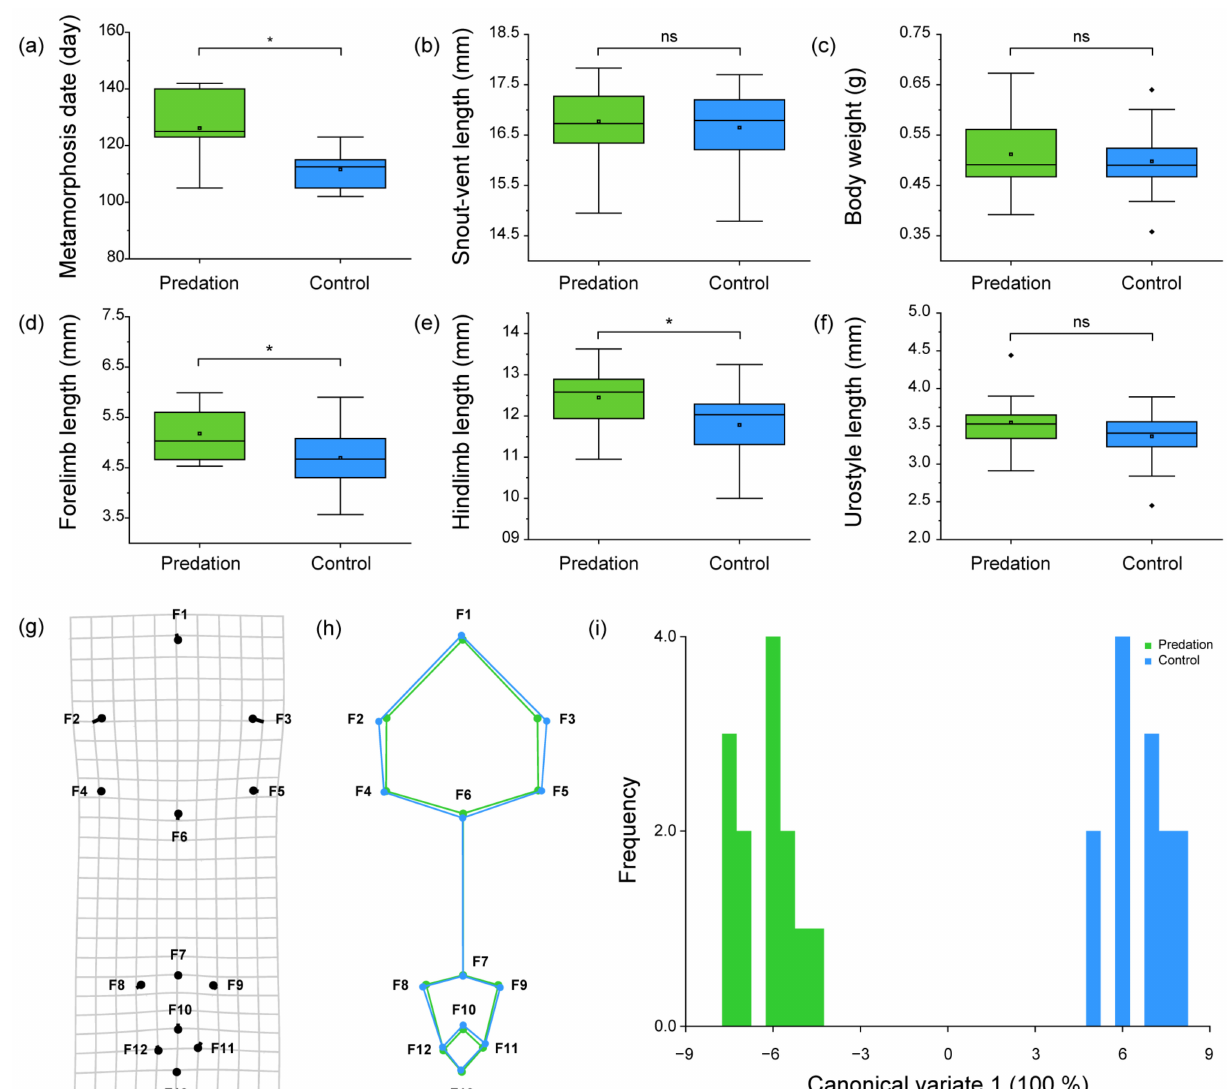
Figure 5. Comparison of the: ( a ) metamorphosis rate; ( b ) snout–vent length; ( c ) body weight; ( d ) forelimb (i.e., the humerus and radio–ulna) length; ( e ) hind limb (i.e., the femur and tibio–fibula) length; ( f ) urostyle length; and ( g – i ) the skeletal shape of the head and lower body of the juvenile frogs (Gosner stage 46) between the predation and control groups; ( g ) the rectangular grid with landmark points and vectors of the canonical variate 1 (CV1); ( h ) the wireframe graph of juvenile frogs in the predation and control groups in respect to the CV1; and ( i ) the distribution of the CV1 value in juvenile frogs between the predation and control groups. The green and blue boxes represent the tadpoles from the predation and control groups, respectively. The box plots show the: mean (central square dot); median (central band); 25th and 75th percentiles (the bottom and top of the boxes); range within a 1.5 interquartile (the bottom and top of the line); and outlier (the diamond dots). Significant differences ( p < 0.05) were determined using an unpaired t -test and are represented with an asterisk (*). Circles in the deformation grid, as well as the green points and lines in the wireframe graph indicate the skeletal shape of the individuals with the lowest CV value. Sticks in the deformation grid, as well as the blue points and lines in the wireframe graph, indicate the change in skeletal shape by an increase in CV